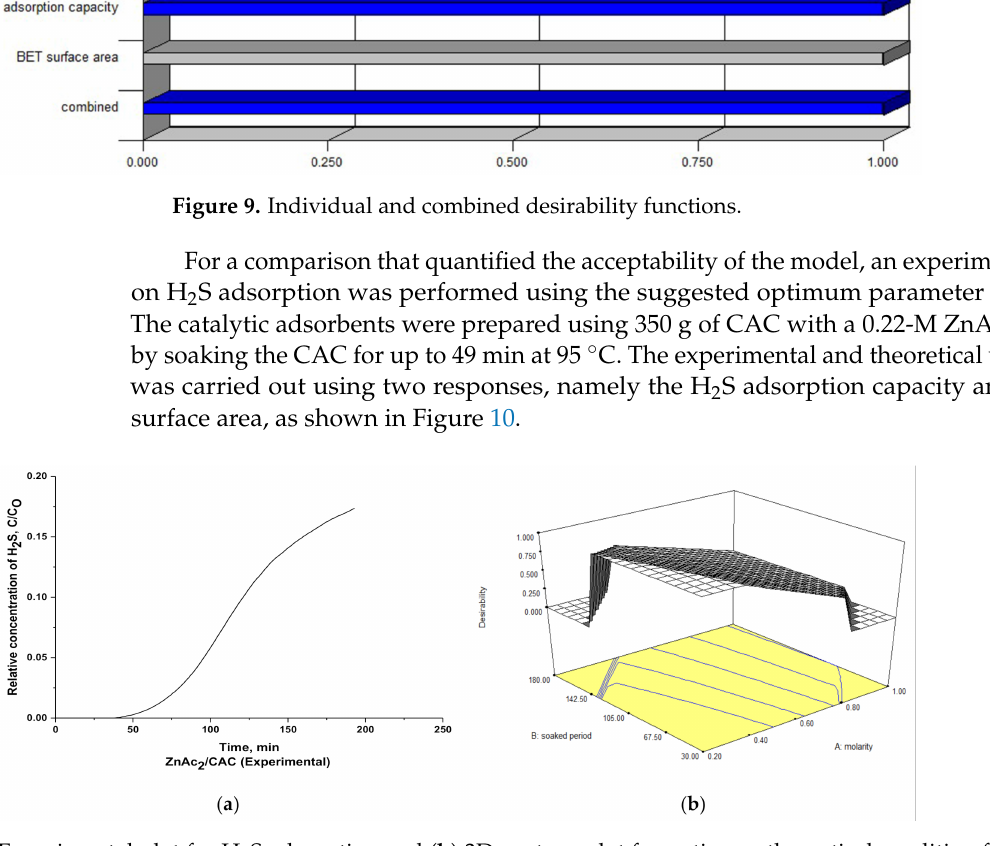
Figure 10. ( a ) Experimental plot for H 2 S adsorption and ( b ) 3D contour plot for optimum theoretical condition for H 2 S adsorption